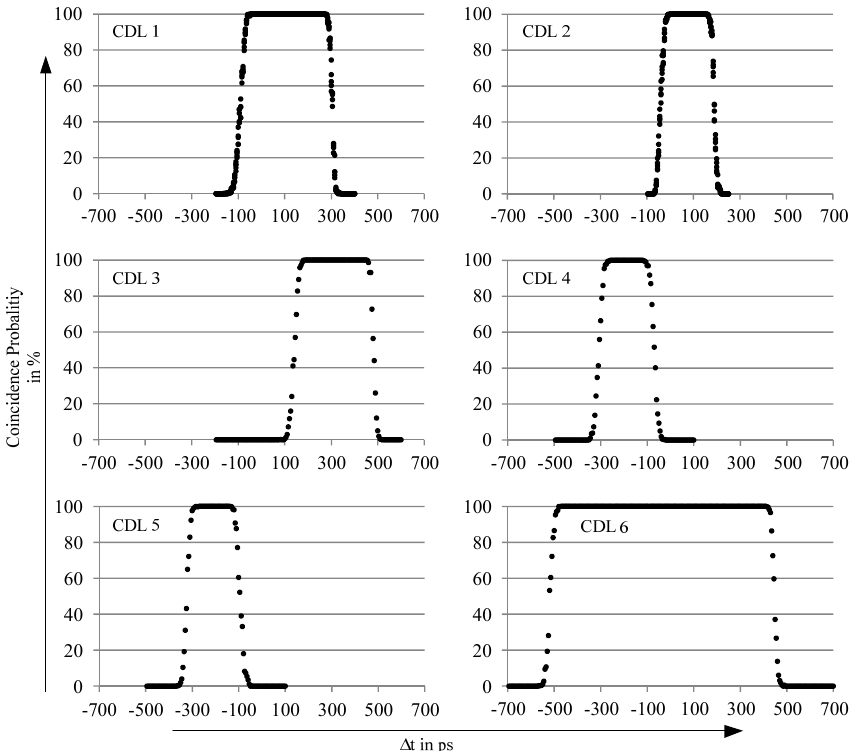
Figure 9. Coincidence windows for different setups of the CDL on a Cyclone II FPGA. The time axis for all tests is defined by the Keysight function